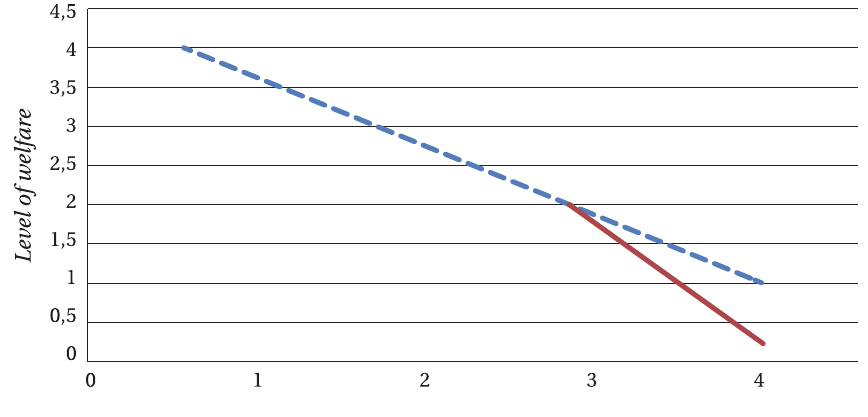
Figure 2.2* The Shift Thesis as plural sets of